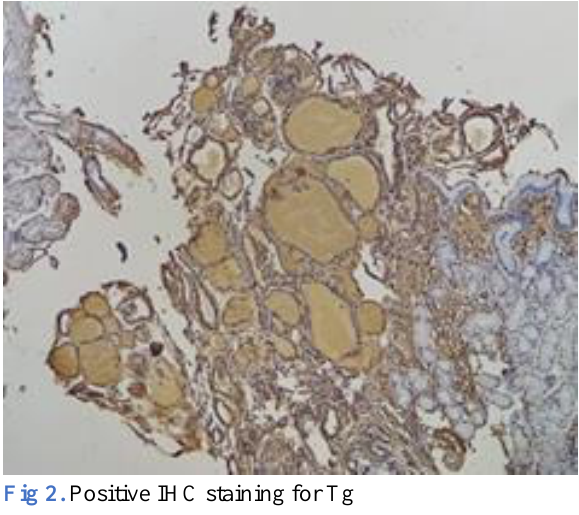
Fig 2. Positive IHC staining for Tg The patient was euthyroid and had normal thyroid appearance in sonography (no thyroid nodule or suspicious lymph